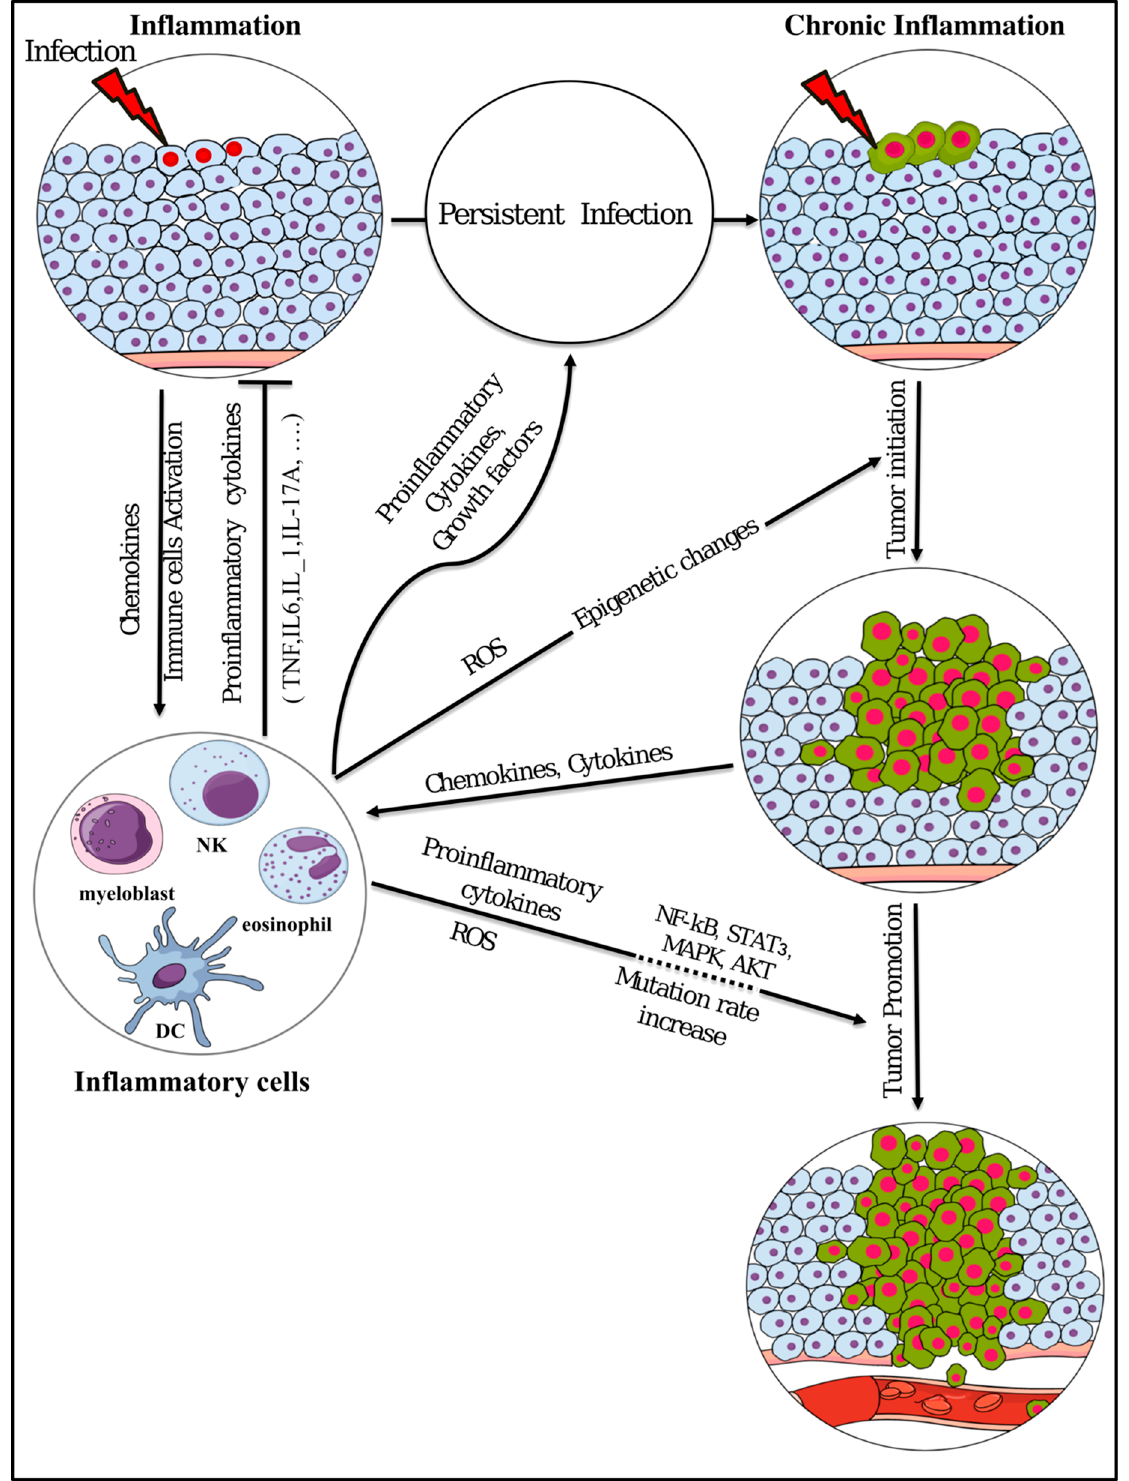
Figure 3. Summary of inflammation involvement in tumor initiation and promotion. ROS: reactive oxygen species; DC: dendritic cell; NK: natural killer.